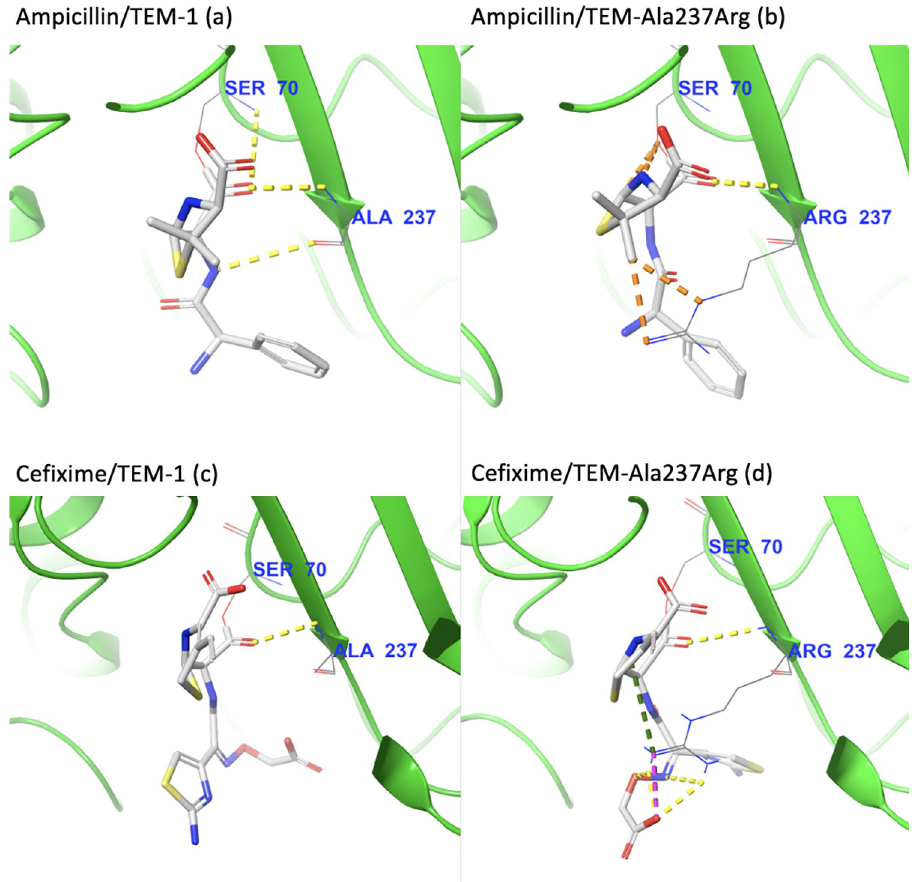
Fig 5. Visual inspection of the intermolecular interactions with key active site residue 237 for ampicillin covalently bound to (a) TEM-1 and (b) TEM-Ala237Arg, and of cefixime covalently bound to (c) TEM-1 and (d) TEM-Ala237Arg. Yellow dotted lines indicate hydrogen interactions, orange dotted lines indicate poor contacts/ clashes, purple dotted lines indicate salt bridges, and green dotted lines indicate cation-pi interactions.